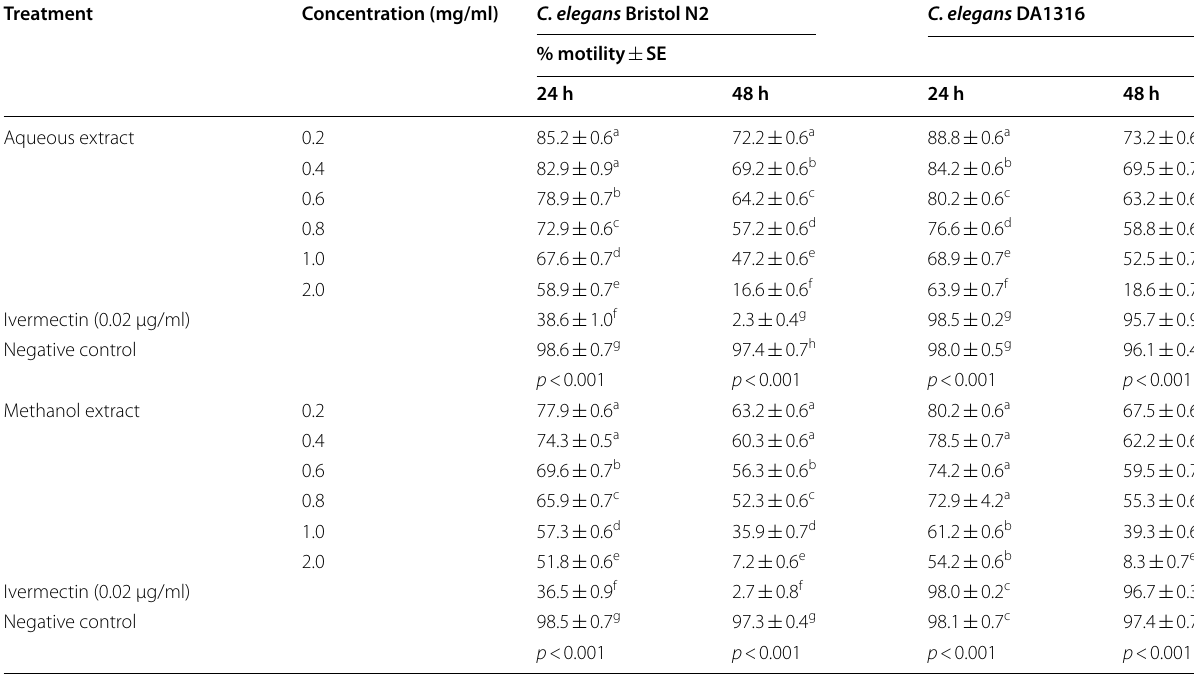
Motility values with the same alphabet in the same column for the same extract treatments are not significantly different at p < 0.05 (Tukey’s HSD